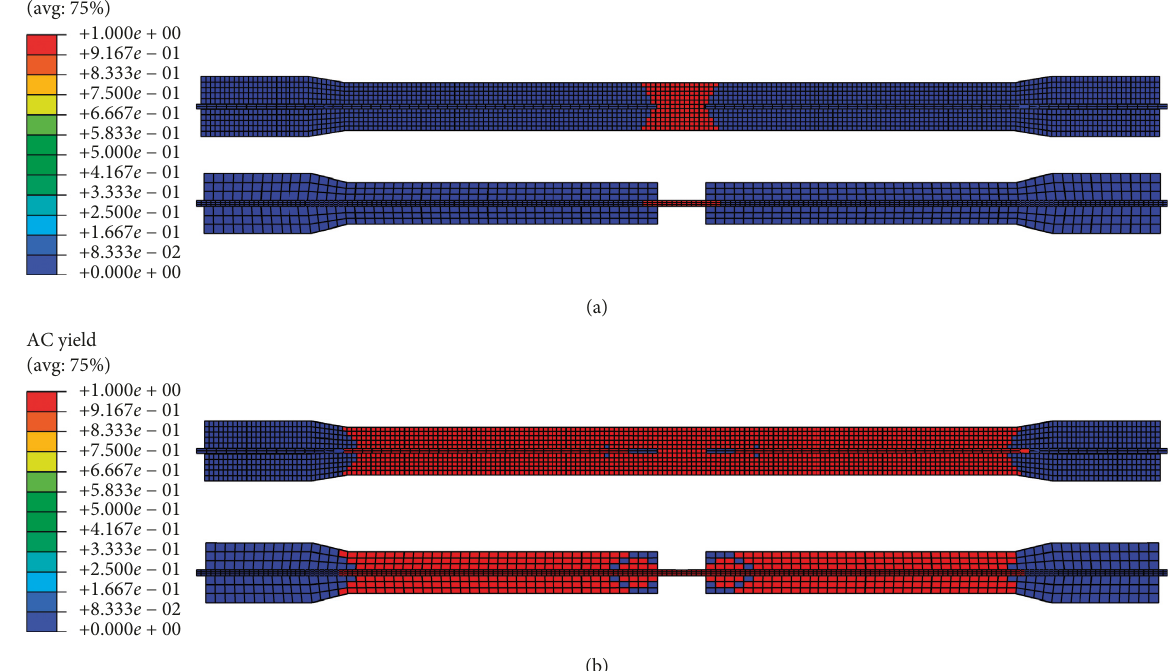
Figure 18: AC yield of the BRB-VCC-7 core. (a) Flat-plate segments yield firstly ( δ segments yield soon later ( δ y2 � 1.52mm and F y2 � 333.4kN). Note: AC YIELD is 1.0 in the plastic region and is 0 in the elastic region.